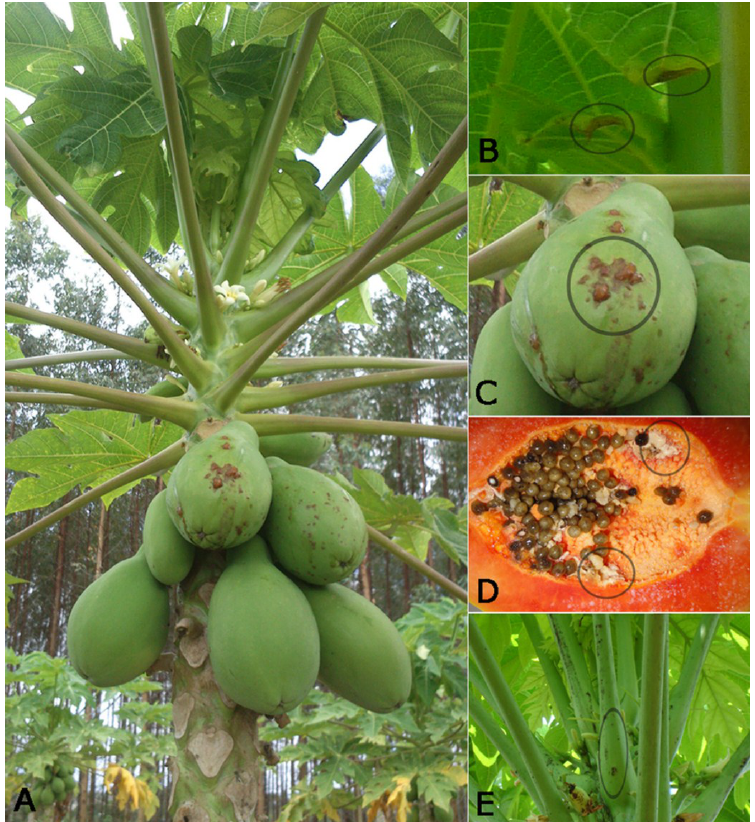
Figure 2. Symptoms of PMeV infection in Carica papaya . Papaya plant showing the symptoms of sticky disease ( A ). Plants spontaneously leak the latex, which oxidizes after atmospheric exposure resulting in small necrotic lesions on the edges of young leaves ( B ) and fruits with sticky aspect ( C ). Additionally, diseased plants in Mexico show latex inside of the fruit cavity ( D ) and necrotic spots in the petioles ( E ). The black circles highlight the main symptoms. Initially, symptoms of the disease were attributed to a disturbance in the calcium and boron absorption that resulted from water stress or an imbalance of these elements in the soil [16]. In addition to the abiotic factors, the involvement of microorganisms was suggested after the isolation of a bacteria of the genus Bartonella from the diseased plants